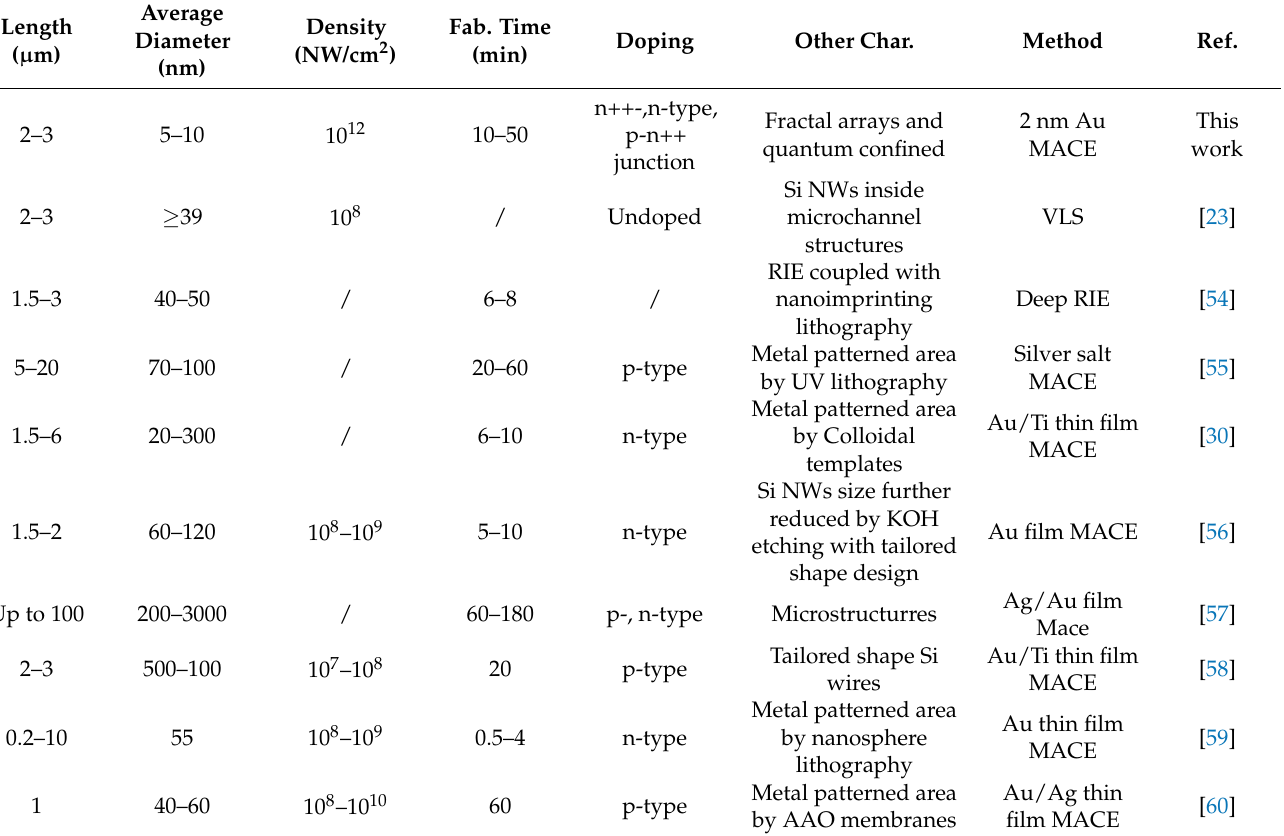
Table 1. Comparison between Si NWs in this work and